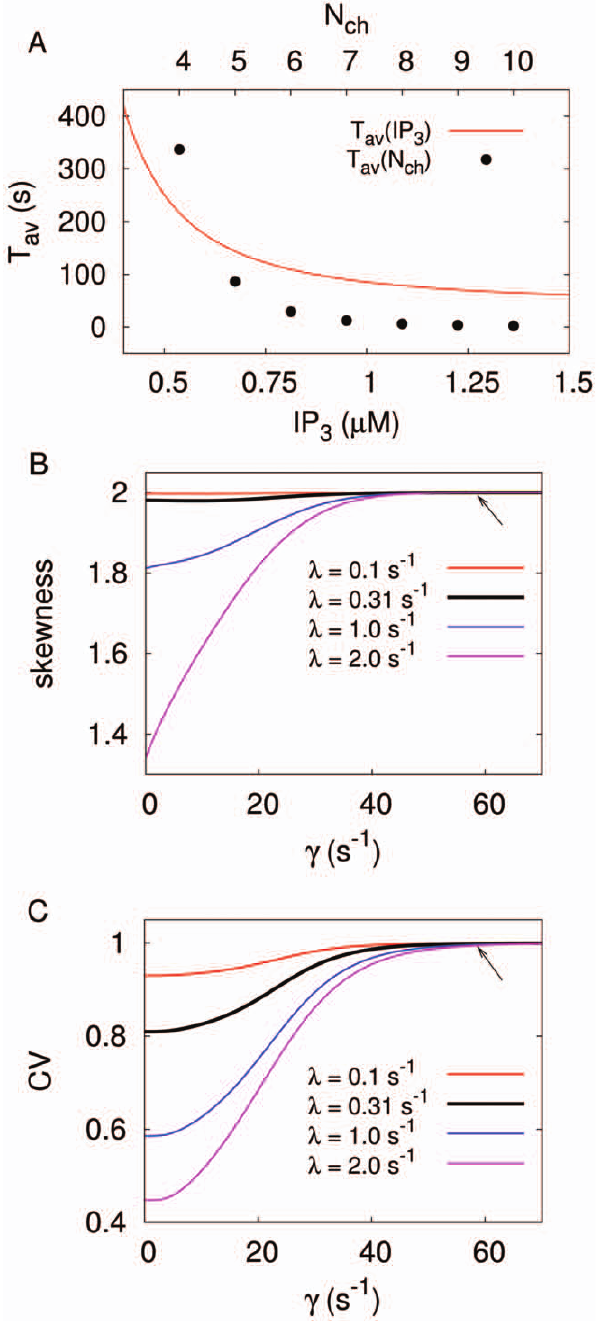
Figure 4. Statistical analysis of Ca 2 z interspike intervals (ISI). (A) The average ISI T av decreases with the IP 3 concentration ( N ch =5) and with N ch ( ½ IP 3 (cid:2) =1 m M ). The other parameter is kept at N ch =5 and ½ IP 3 (cid:2) =1 m M , respectively. (B) Skewness and (C) coefficient of variation (CV=standard deviation/mean) increase with the channel closing rate c , which controls the time scale separation between Ca 2 z puffs (single cluster opening) and Ca 2 z spikes (all clusters open). The solid lines are calculated for a realistic puff rate l 0 . The dotted lines indicate that the time-scale separation becomes weaker with growing puff rate (see text). The parameter values used for the stochastic Ca 2 z model (Fig. 3) are indicated by the arrows.